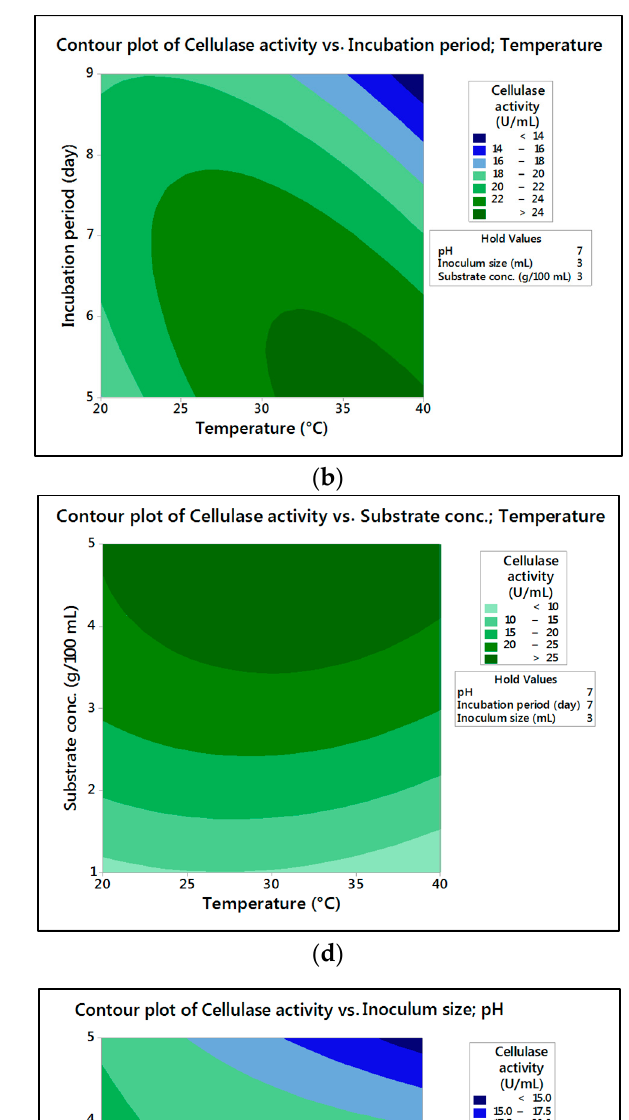
Figure 3. Contour plot showing interactions between independent variables: ( a ) incubation tem- perature with pH; ( b ) incubation temperature with incubation period; ( c ) incubation temperature with inoculum size; ( d ) incubation temperature with substrate concentration; ( e ) pH with incuba- tion period; ( f ) pH with inoculum size; ( g ) pH with substrate concentration; ( h ) incubation period with inoculum size; ( i ) incubation period with substrate concentration; ( j ) inoculum size with sub- strate concentration for cellulase activity produced by M. circinelloides .